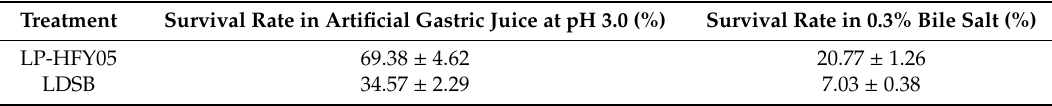
Table 3. Resistance of LAB to artificial gastric juice and bile